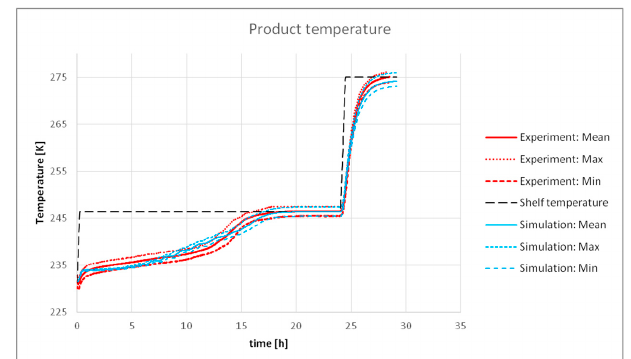
Figure 14. Comparison of experimental ( red ) and simulated ( blue ) product temperatures. The average shelf temperature is represented by the black dashed line.